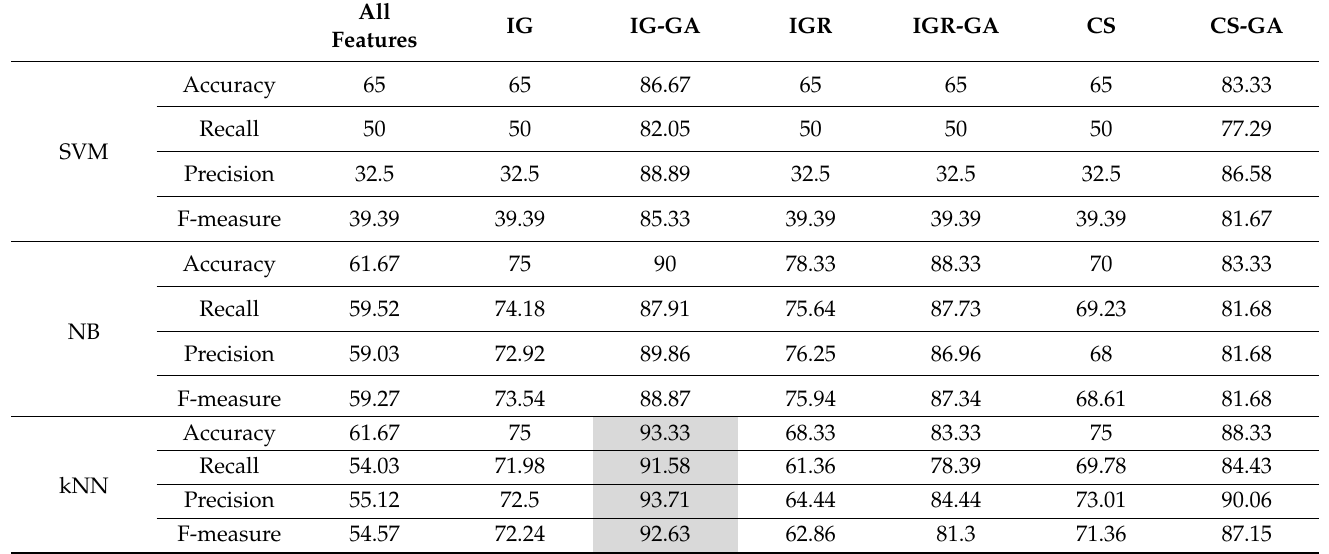
Table 6. The performance comparison of classifiers using all features, the features selected by